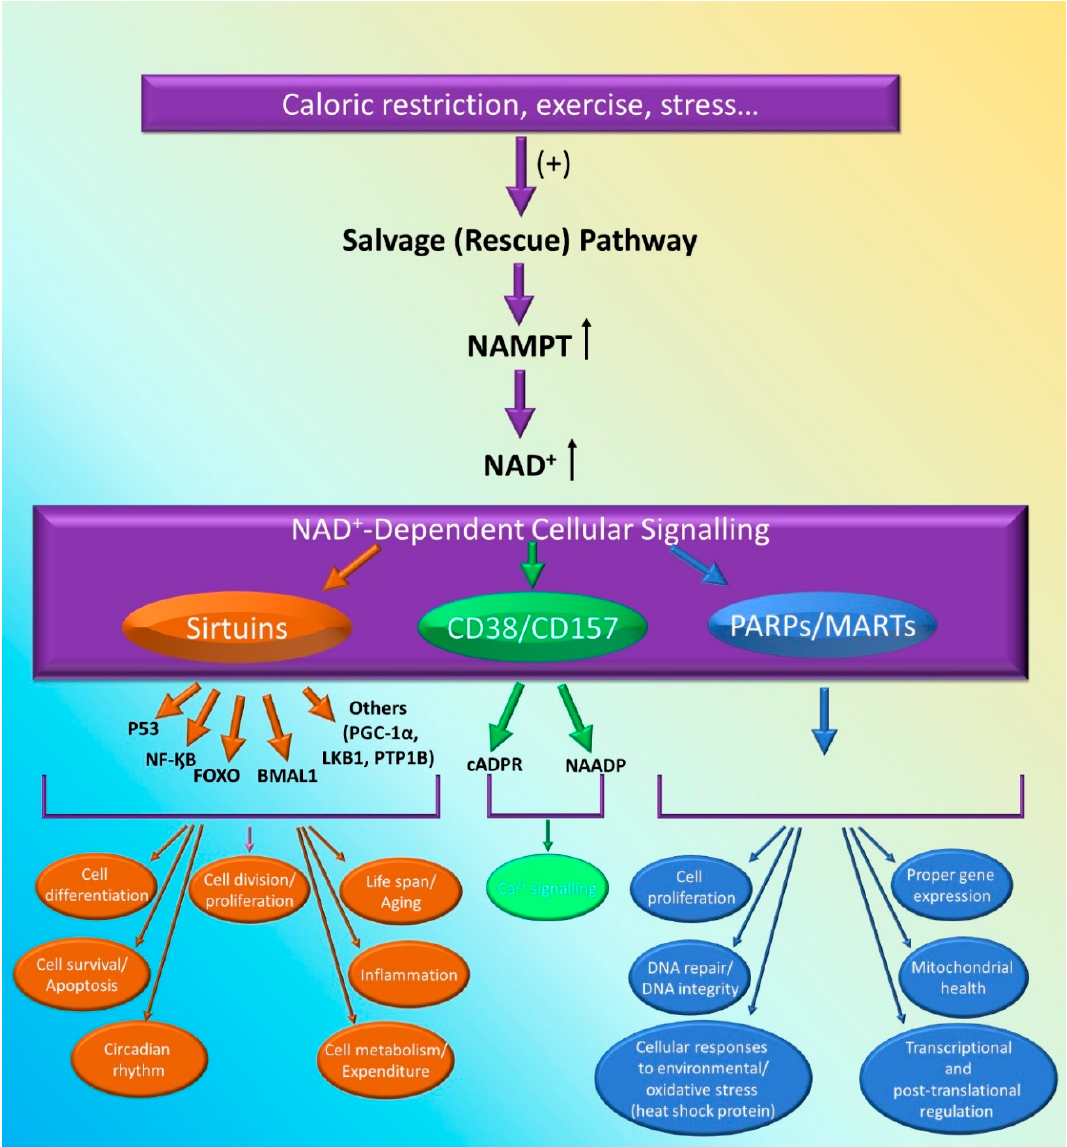
Figure 2. The salvage (rescue) pathway remains a predominant pathway to meet NAD+ cellular requirements. Several NAD + dependent cellular signaling pathways exist and involve sirtuins, CD38/CD157, and PARPs/MARTs. They are essential for various cellular biological functions such as cellular division, proliferation, inflammation, maintaining genome integrity, DNA and protein synthesis, cellular anti-oxidative power, cellular metabolism, energy expenditure, mitochondrial health, and aging. FOXO: fork-head box class O; BMAL1: brain and muscle aryl hydrocarbon receptor nuclear translocator-like.